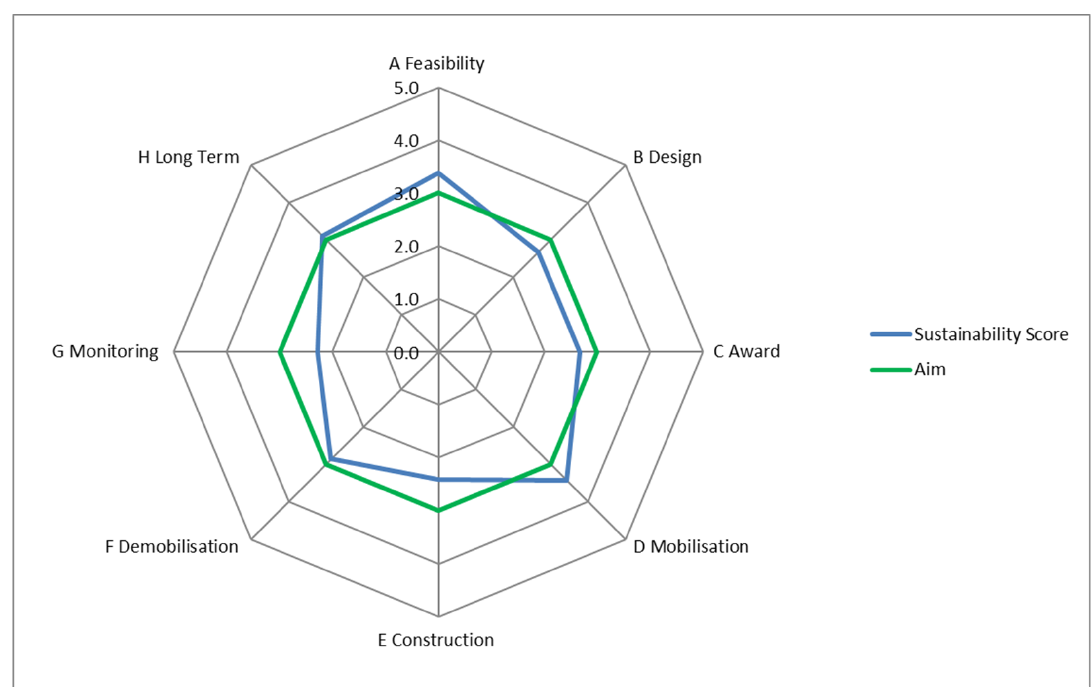
Figure 5. Average scores per project stage for all 23 case studies.